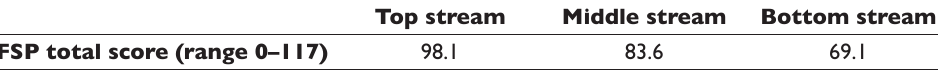
Table 3: Mean total FSP score at age 5 (a)